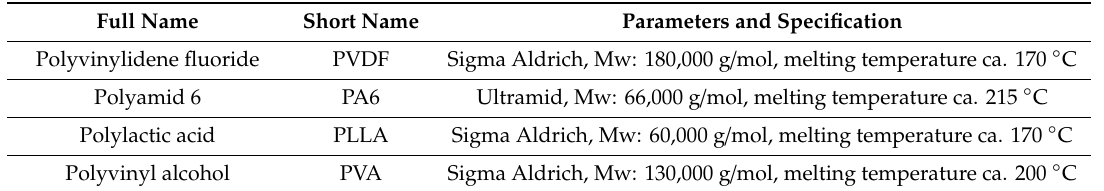
Table 1. Electrospun